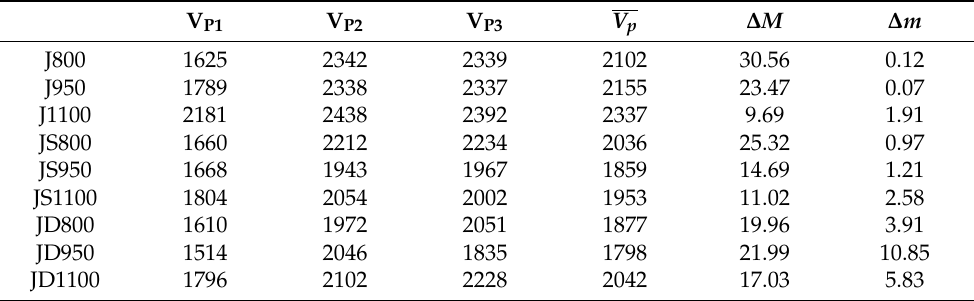
Table 4. Speed of ultrasonic wave propagation (in m/s), mean velocity ( V p , in m/s), structural ( ∆ M ), and relative ( ∆ m ) anisotropies (in %) of bricks with and without additives fired at 800, 950, and 1100 ◦ C. V P 1 , V P 2 , and V P 3 are the ultrasound velocities measured in three orthogonal